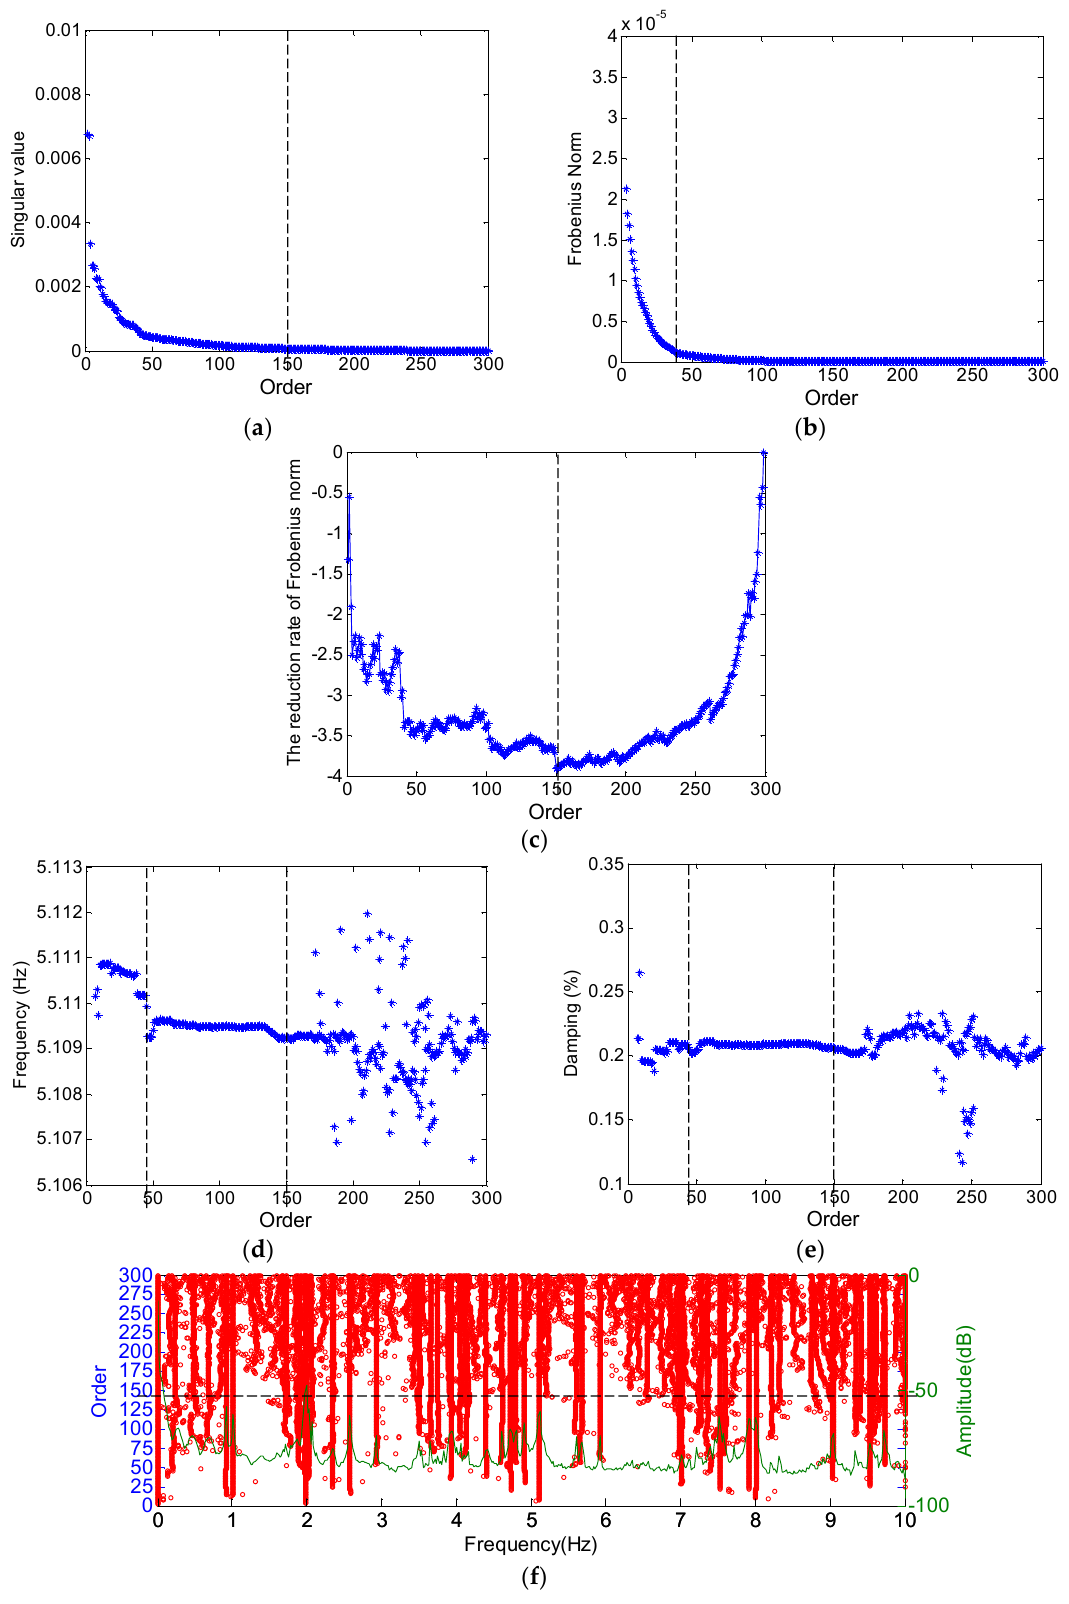
Figure 2. Determination of the model order: ( a ) singular value; ( b ) the Frobenius norm between the original and the estimated Toeplitz; ( c ) the reduction rate of the Frobenius norm; ( d ) identified frequencies; ( e ) identified damping ratio; and ( f ) identified poles by selecting the maximum